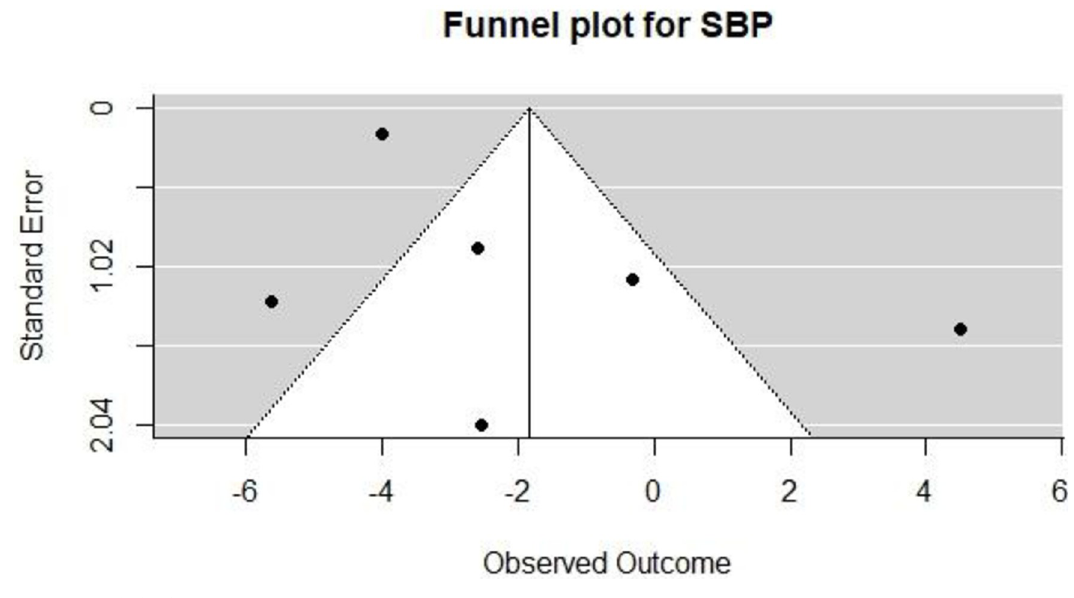
Fig 4. Funnel plot for